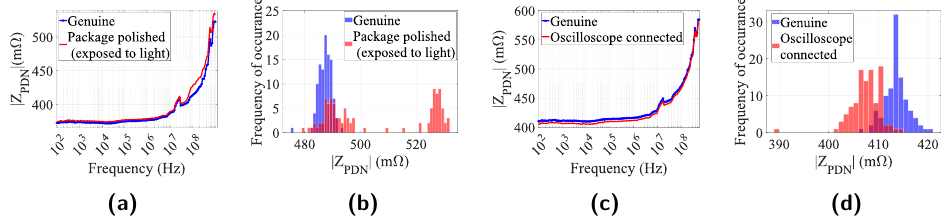
Figure 12: (a) The mean of 105 impedance profile signatures for polishing the FPGA package and measuring impedance profile in a room exposed to light. (b) Histograms at f = 388 . 61 MHz for polishing the FPGA package in a room exposed to light. (c) The mean of 105 impedance profile signatures for connecting the oscilloscope probe to the DUT. (d) Histograms at f = 53 . 15 kHz for connecting the oscilloscope probe to the DUT.